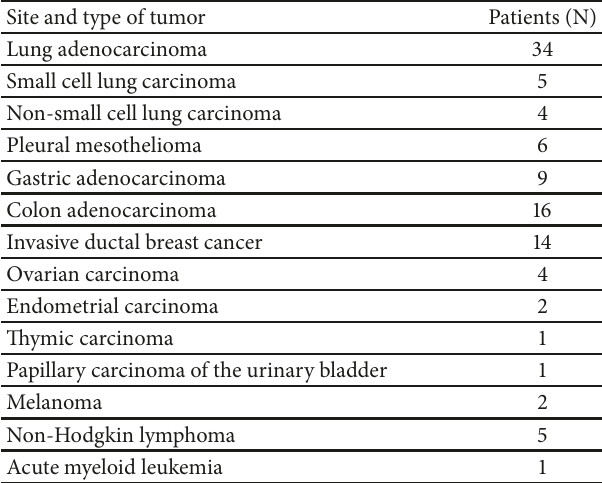
Table 1: Primary origin and type of malignant disease in patients with malignant pleural effusion.